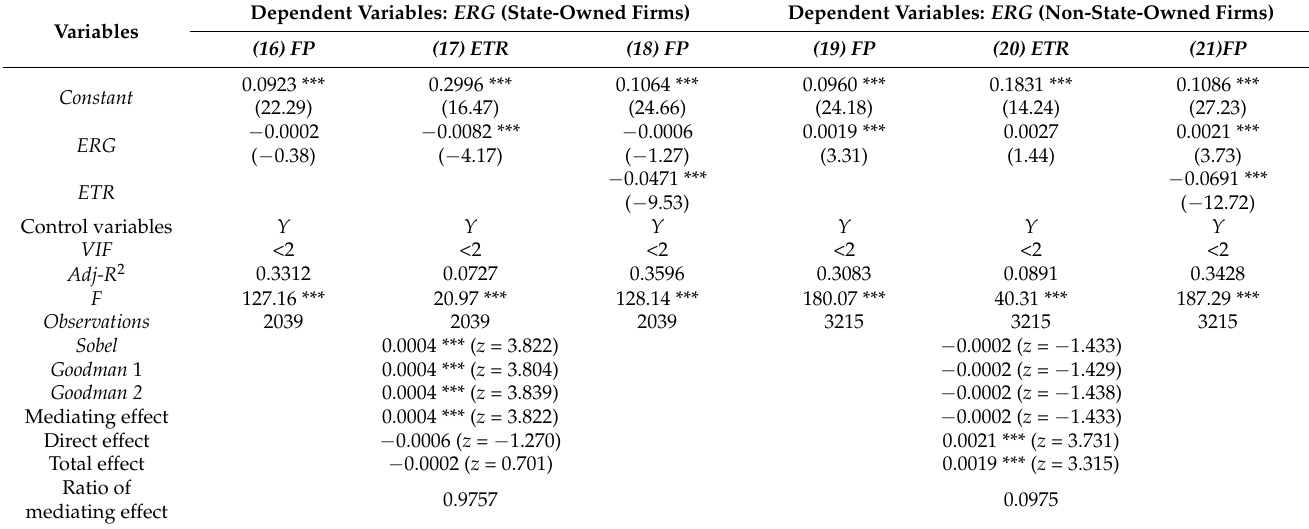
Table 8. Considering Firm